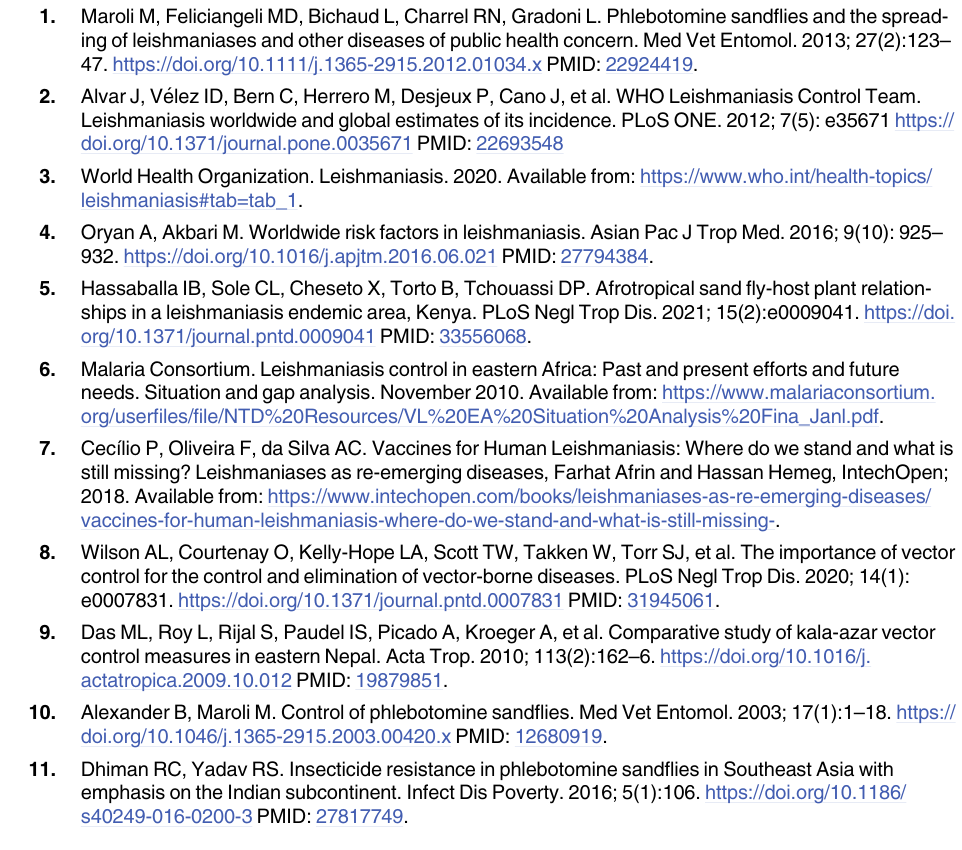
S1 Table. Insecticide resistance bioassay records in Phlebotomus and Lutzomyia vector spe- cies populations